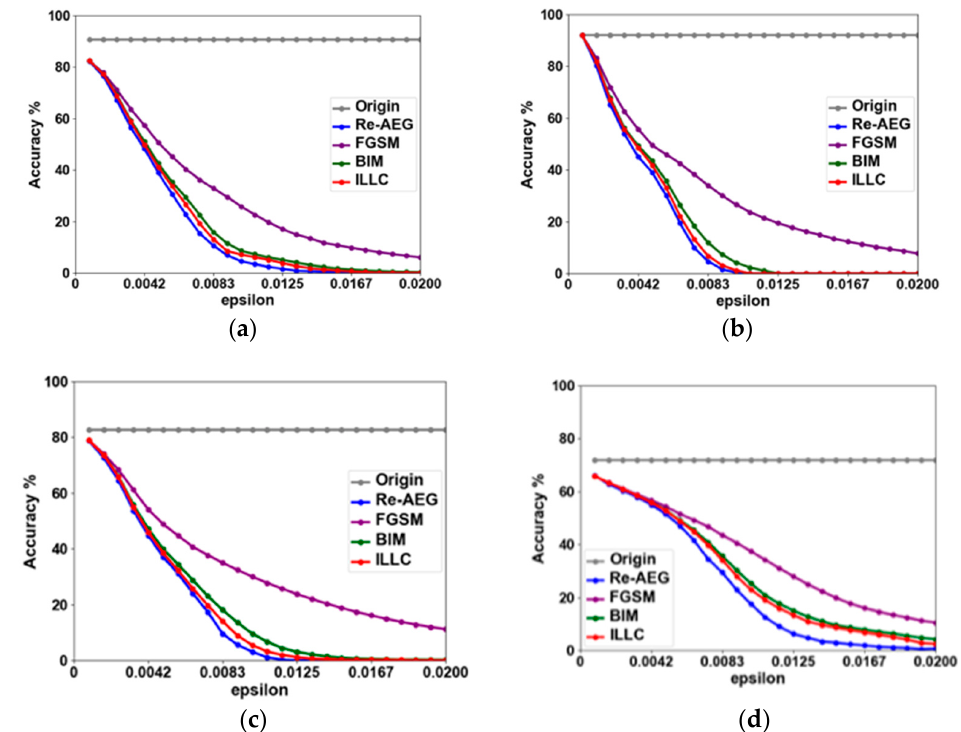
Figure 9. Comparison of different models. ( a ) Inception;( b ) VGGNet16; ( c ) ResNet-50; ( d ) IncRes152.